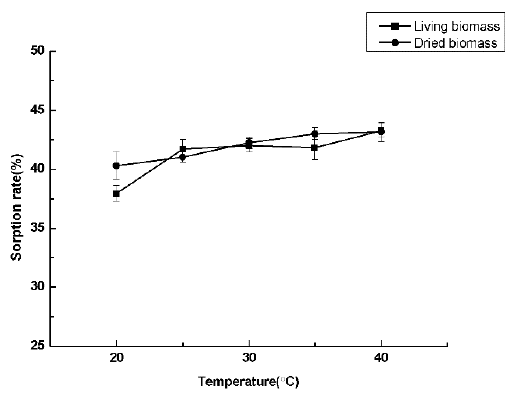
Figure 10. Temperature effect of both biomass sorption patterns. ( p = 0.048).